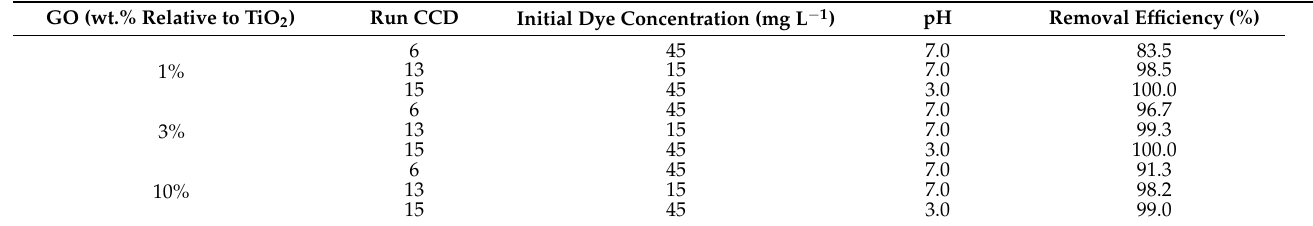
Table 5. GO effect in the removal efficiency of FD&C Red 40 dye.